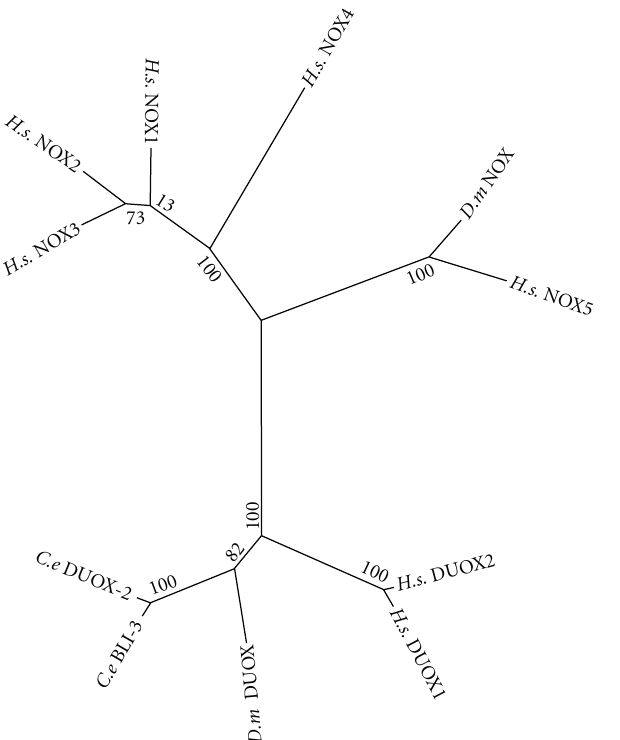
Figure 9: Maximum likelihood majority-rule bootstrap consensus tree of NADPH oxidase (NOX)/dual oxidase (DUOX) proteins. See Figure 5 for details of how the sequences were identified and